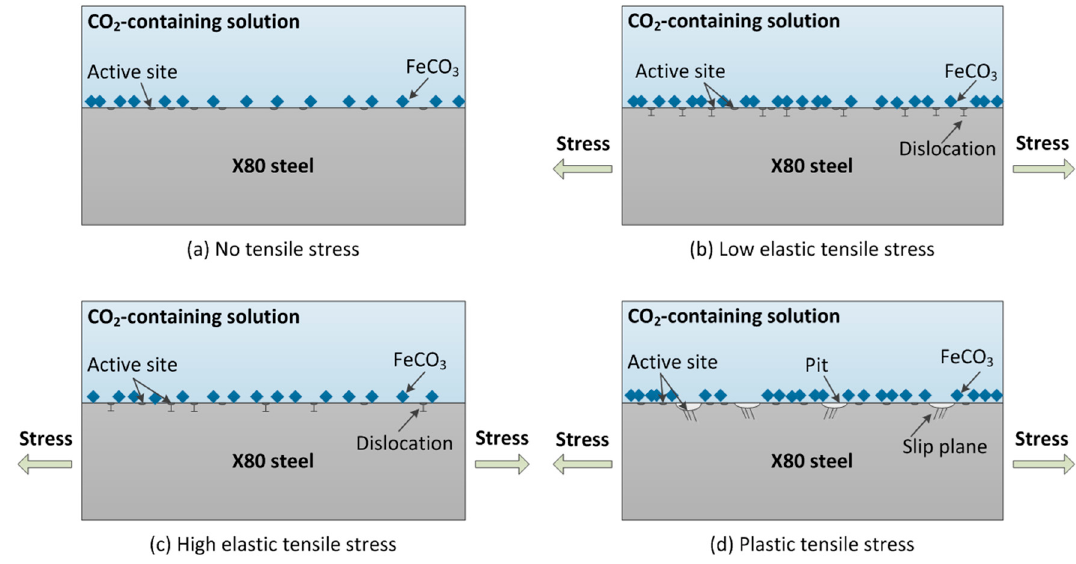
Figure 12. Schematic of corrosion of stressed X80 steel in CO 2 environment.